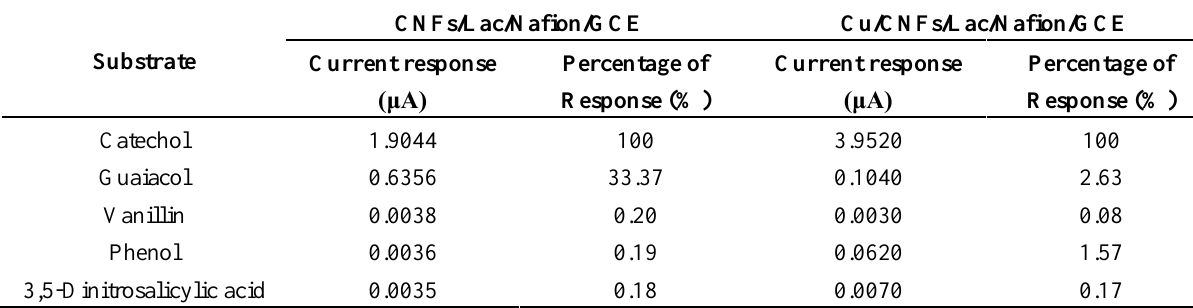
Table 1. Biosensor response to various